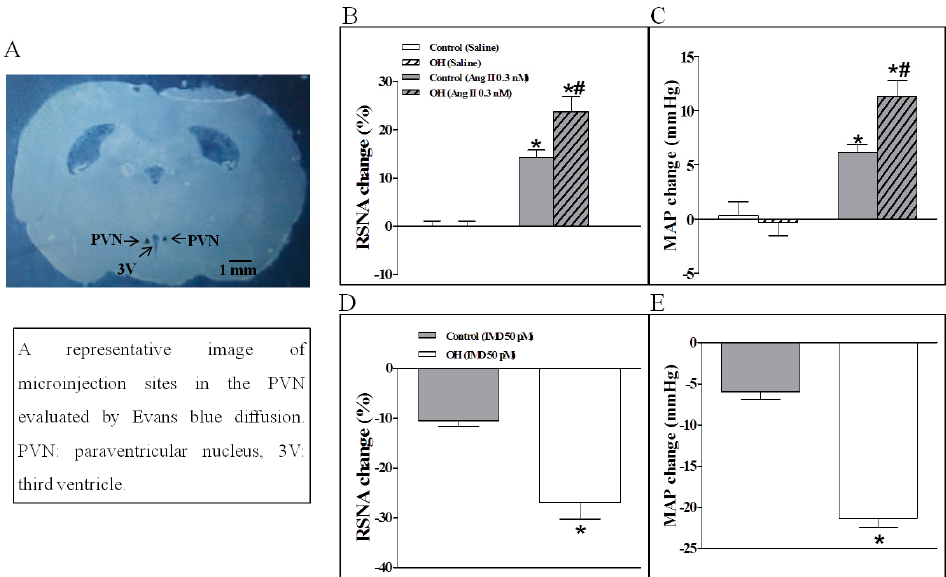
Figure 2. A representative image of microinjection sites in the PVN evaluated by Evans blue diffusion ( A ), and the effects of a PVN microinjection of saline, Angiotensin II (Ang II, 0.3 nM) ( B , C ) or intermedin (IMD, 50 pM) ( D , E ) on the renal sympathetic nerve activity (RSNA) and mean arterial pressure (MAP) in control and OH rats. Values are mean ± SEM. * p < 0.05 versus saline; # p < 0.05 versus control ( B , C ). * p < 0.05 versus control ( D , E ). n = 6 for each group.